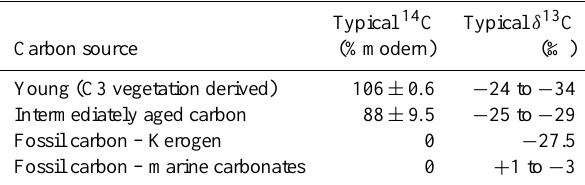
Table 1. Estimated average 14 C concentrations (%modern) and δ 13 C signatures of the potential end members at the Tambopata site. Intermediately aged carbon date range is ∼ 200–2000yrBP (where 0BP = 1950AD) which represents the age of material that could be derived from aged soil carbon, Holocene fire black carbon and re- working of the Tambopata River bank terraces. The Main Trail con- centration was selected to represent the recent carbon inputs into the mixing model to solve the end members for the other three drainage